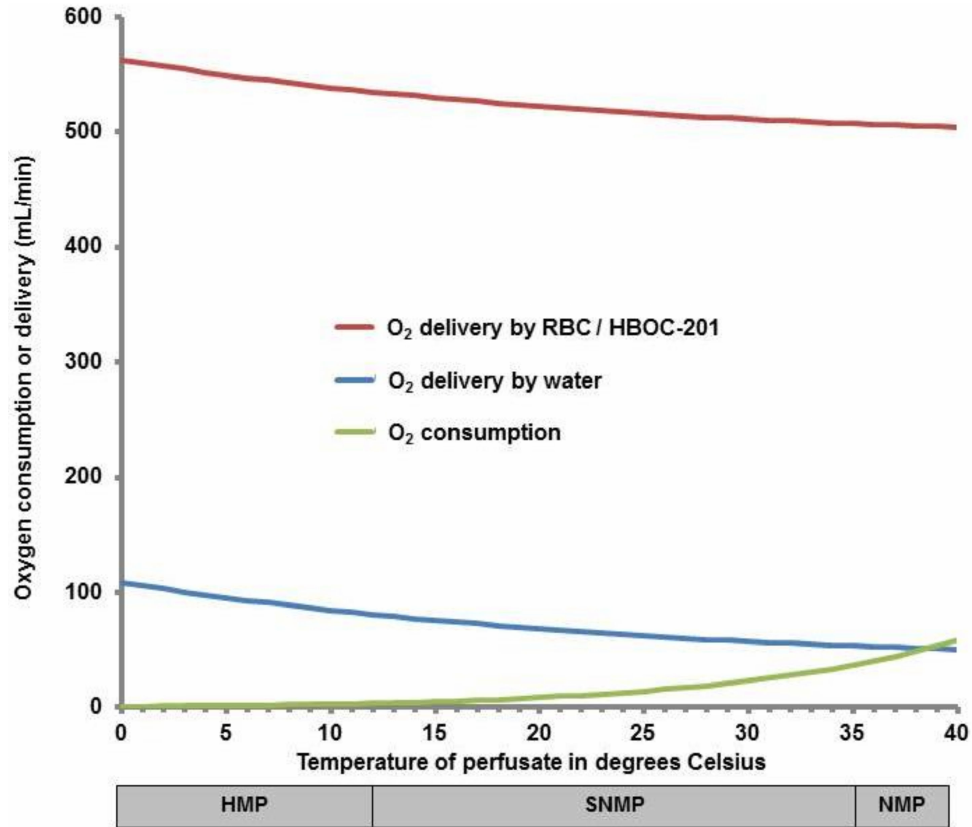
Figure 2. Graphical presentation of the relation between perfusion temperature and oxygen (O 2 ) consumption (green curve) and O 2 delivery. Metabolic rate and O 2 consumption rise with approxi- mately 10% for each increase in temperature measured in degrees Celsius. Note that the amount of O 2 that is dissolved in water (blue curve) decreases at higher temperatures. At body temperature, O 2 consumption/requirement will be larger than the amount that can be delivered by dissolved O 2 alone, as indicated by the crossing green and blue curves. The addition of an oxygen carrier such as red blood cells (RBC) or hemoglobin-based oxygen carrier 201 (HBOC-201; red curve) can dramatically increase O 2 content and delivery. Note that, as in whole body physiology, during organ perfusion oxygen delivery must be considerably higher than oxygen consumption, because oxygen consuming tissues such as the liver [31] can only extract a fraction of the delivered oxygen. The numbers displayed here assume oxygenation with 100% oxygen, a hemoglobin or HBOC-201 concentration equivalent to 7.76 mmol/L of O 2 -binding sites and a perfusion flow of 2300